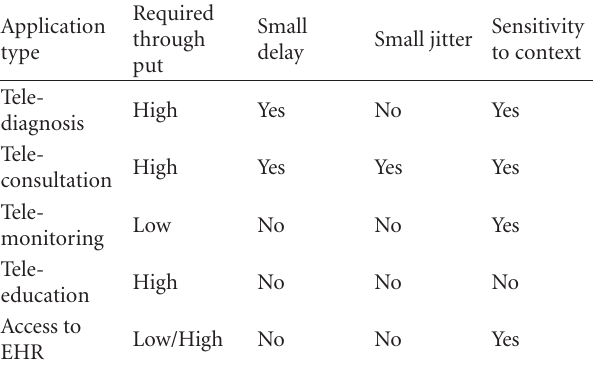
Table 1: QoS requirements for di ff erent types of e-Health services with regard to